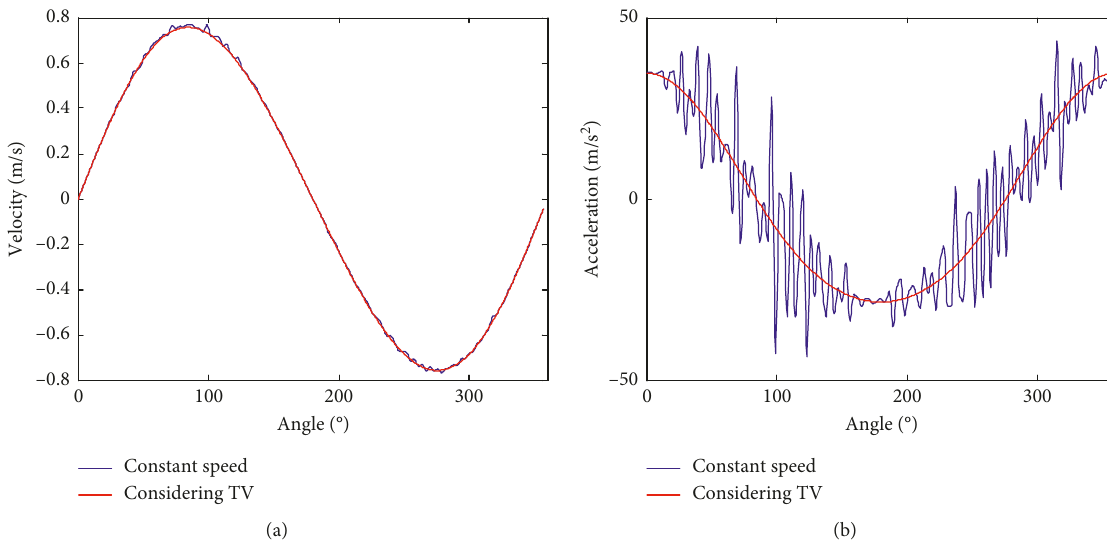
Figure 6: Piston speed (a) and acceleration (b) with and without